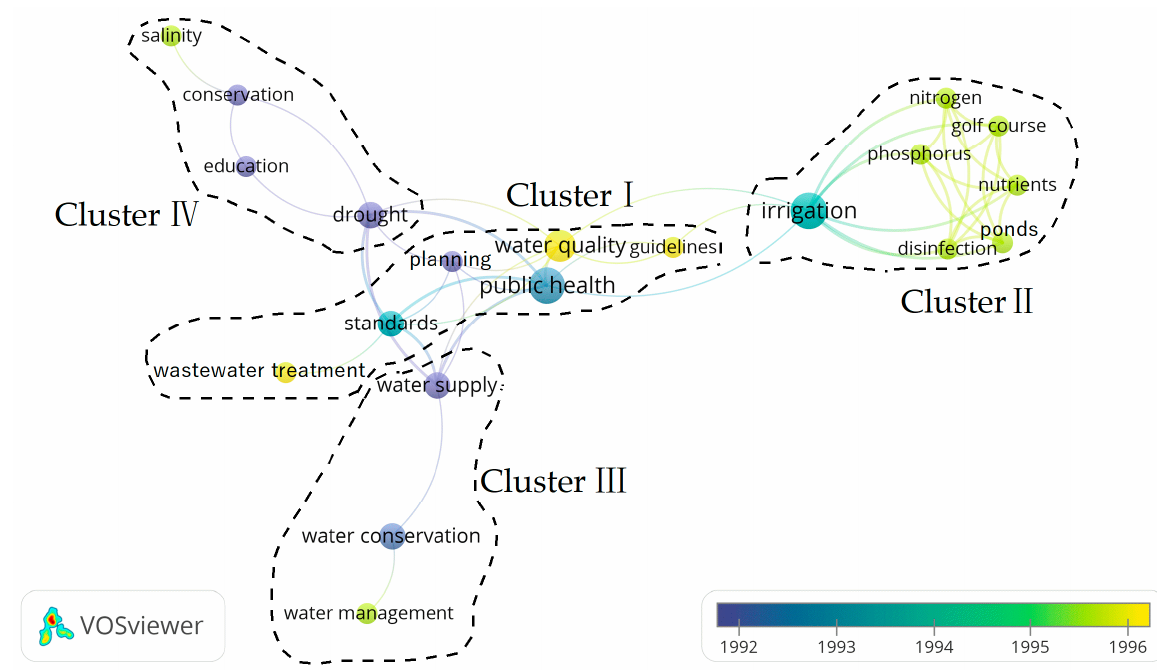
Figure 3. Keyword co-occurrence networks and clusters from 1991 to 2000.